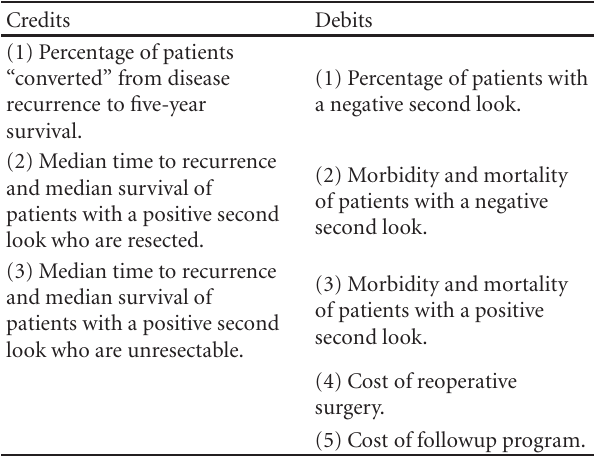
Table 4: Endpoints of revised guidelines for second-look